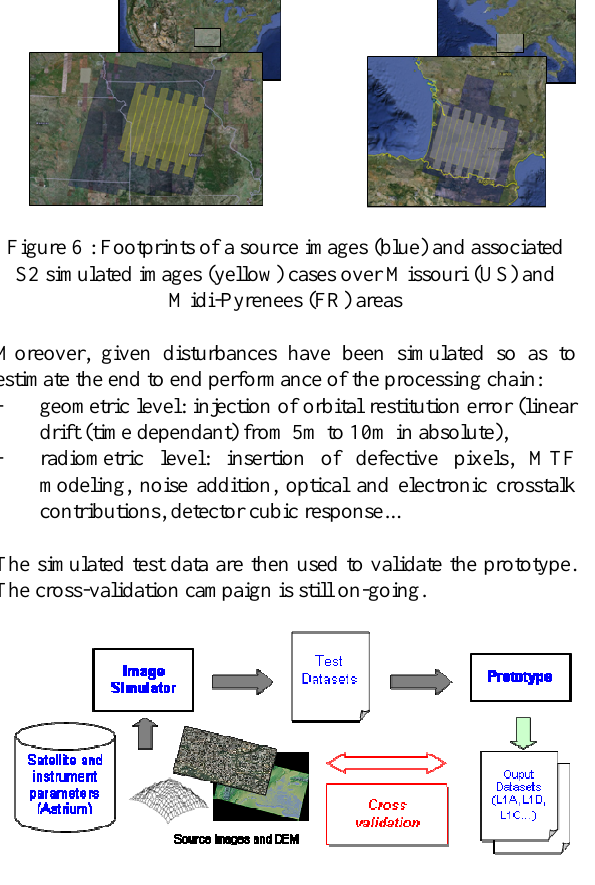
Figure 7: Simulator and prototype